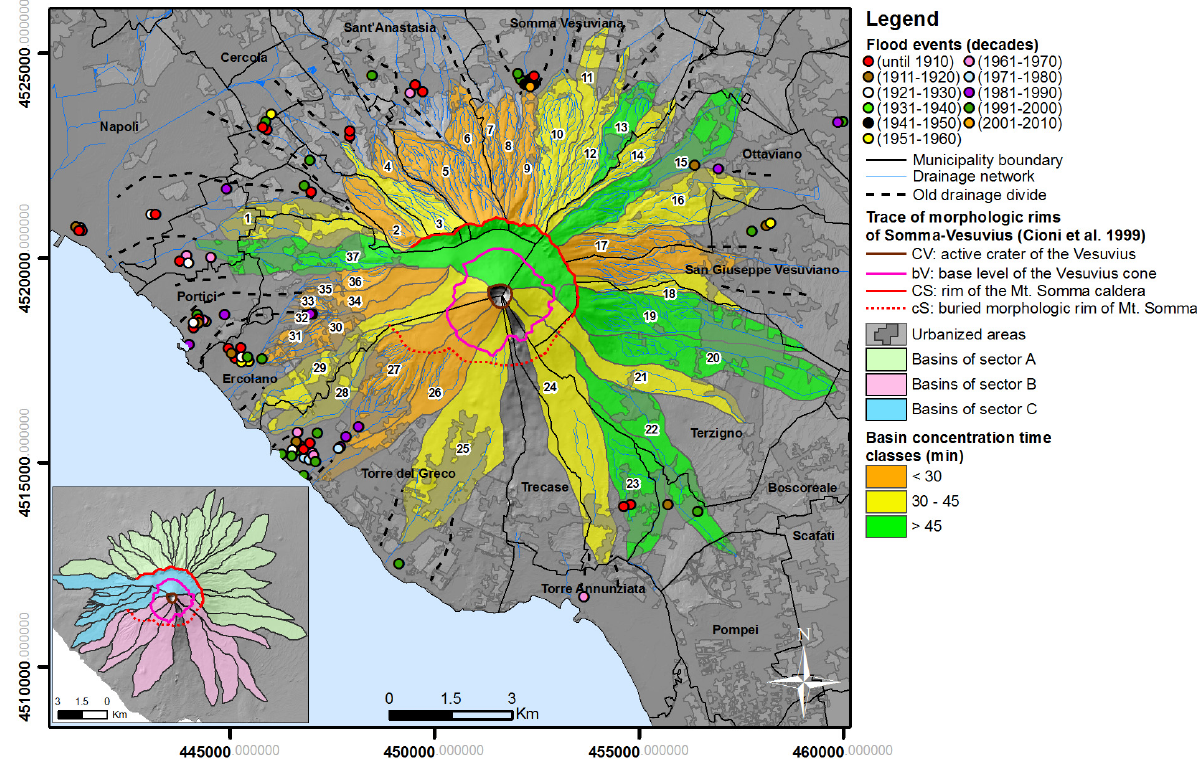
Figure 5. Catchments basins map of the Somma-Vesuvius complex, classified according to three concentration times classes (in minutes), the flood events location and the old drainage divides retrieval in the piedmont area and in the